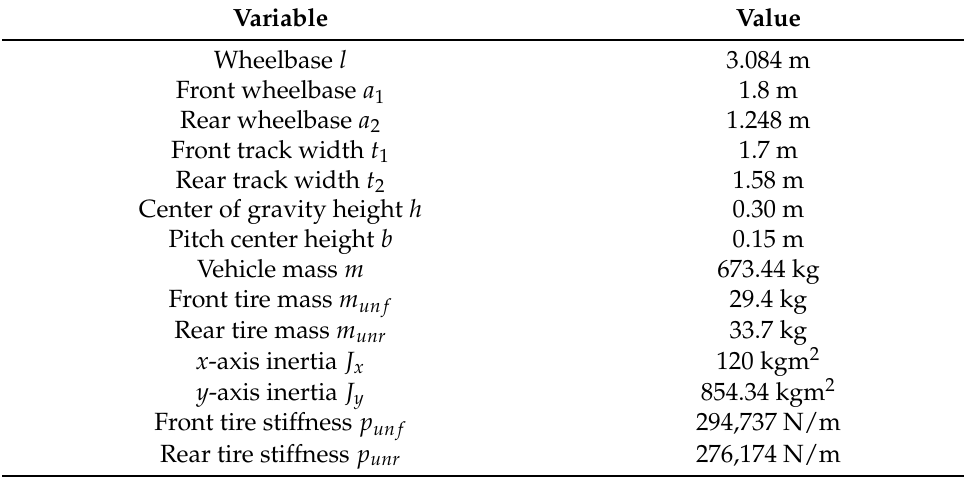
Table 1. IndyCar